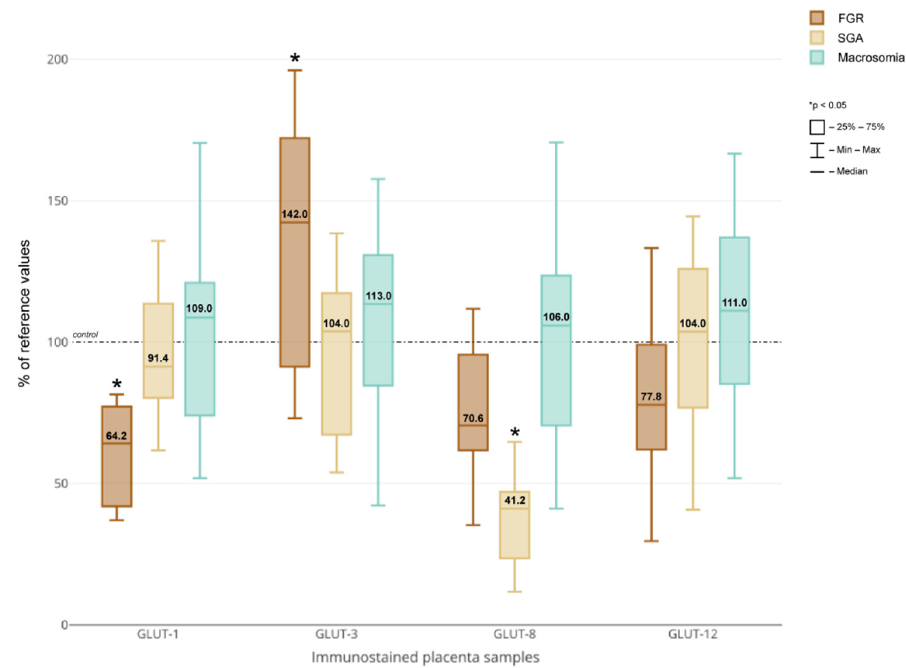
Figure 3. GLUT-1, GLUT-3, GLUT-8 and GLUT-12 protein expression in placental sections obtained from pregnancies with concomitant foetal growth disorders vs. vascular density-matched controls. Median of the percent values and IQR. The median value in the respective controls was taken as 100%. FGR—foetal growth restriction; SGA—small-for-gestational-age.